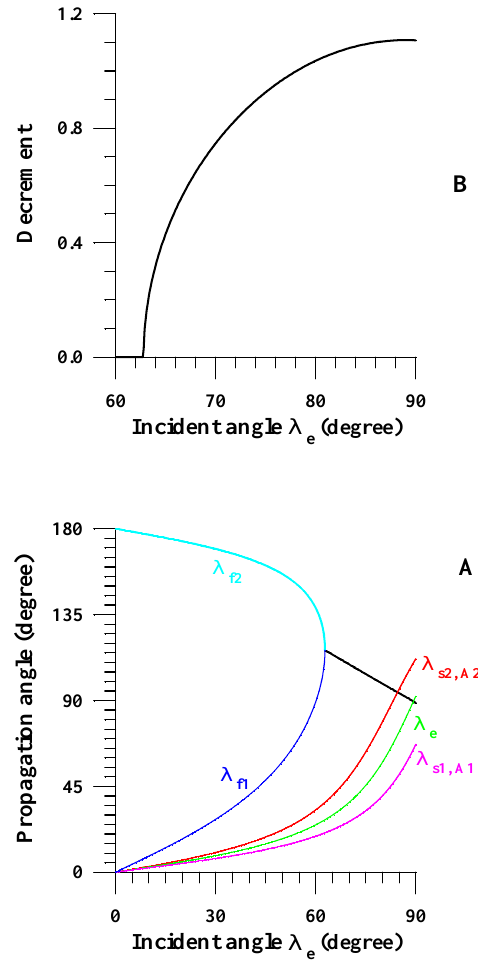
Fig. 1. Propagation angles of all theoretically possible MHD waves (A) and decrement of a surface fast magnetoacoustic wave ( B ) be- hind the front of a sufficiently strong, fast shock wave versus the incident angle of entropy wave λ e . The entropy wave propagates in the uncompressed medium; the incident angle determines the sur- face phase velocity common for all waves propagating in the com- pressed medium. Behind the front of the fast shock wave there can be six diverging modes. They are the forward and backward slow magnetoacoustic waves (denoted by s 1 and s 2 ) , forward and back- ward Alfv´en waves (denoted by A 1 and A 2 ) , entropy wave (de- noted by e) , and fast magnetoacoustic wave (denoted by f 1 ) . Be- sides, there is an incident fast magnetoacoustic wave (denoted by f 2 ) shown with the bold